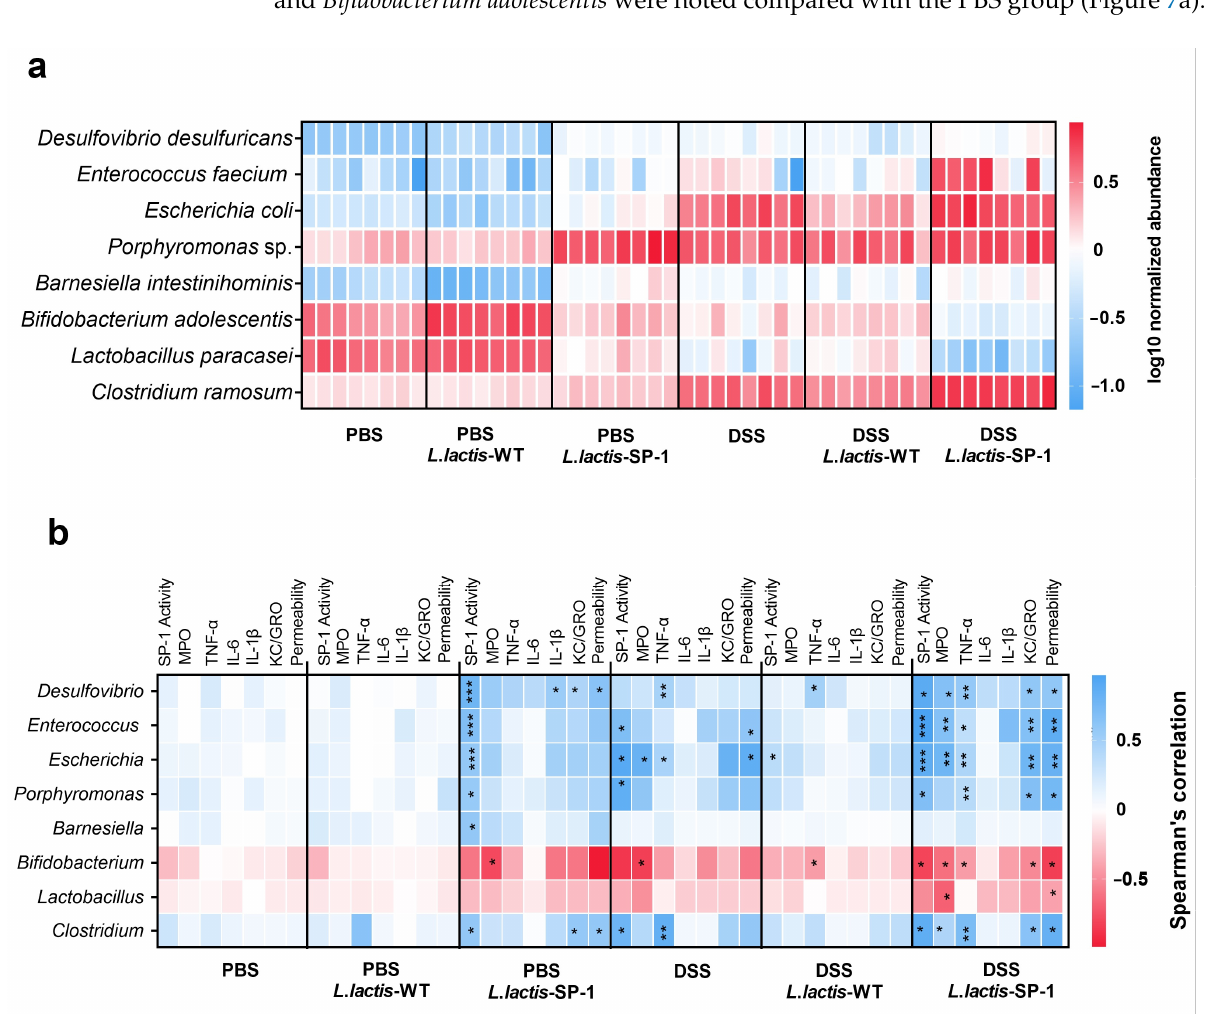
Figure 7. Taxa differentially abundant and correlation with inflammatory parameters. ( a ) Heat map showing the relative abundance (log-transformed) of differentially abundant species between studied groups. ( b ) Spearman correlations between microbial populations and host parameters. The colors denote the nature of the correlation, with dark blue indicating a strong positive correlation and dark red indicating a strong negative correlation.* p < 0.05; ** p < 0.01; *** p < 0.001 after FDR correction.